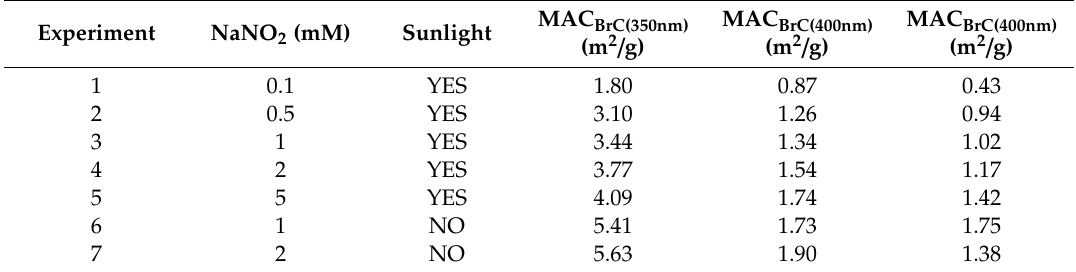
Table 3. Wavelength-dependent mass absorption coe ffi cients (MAC 350 , MAC 400 , and MAC 410 ) for BrC formation during the photolysis of 3-methylcatechol in aqueous NaNO 2 solutions (pH 4–5, T = 25 ◦ C) at di ff erent initial concentrations of NaNO 2 under simulated sunlight (YES) and in the dark (NO). The concentration of 3MC was always 0.1